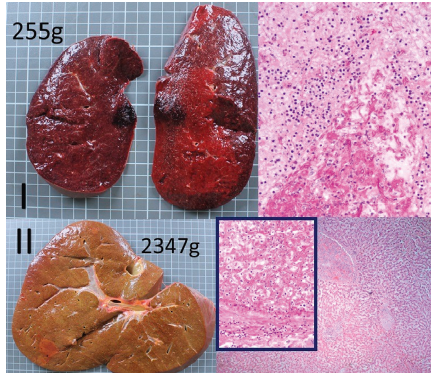
Figure 3: Postmortem autopsy findings revealed significant spleen (I) and liver (II) enlargement, congestion, infarction, and necrosis. Histopathological hematoxylin-eosin stain revealed abundant angioinvasive, aseptate hyphae, consistent with mucorales.